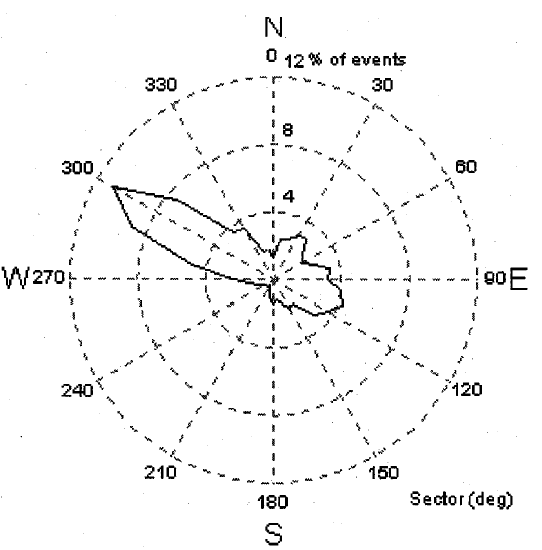
Fig. 7a, b. Wind speed distributions in di(cid:128)erent sectors: a for the 0 (cid:176) – 180 (cid:176) sector and b for the 180 (cid:176) –360 (cid:176) sector. The percentage of events was calculated from the total number of data recorded during the 1997